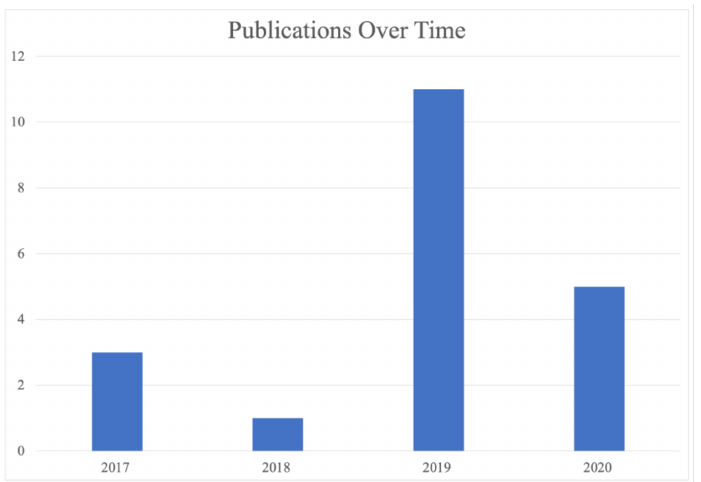
Figure 3. Number of primary studies against